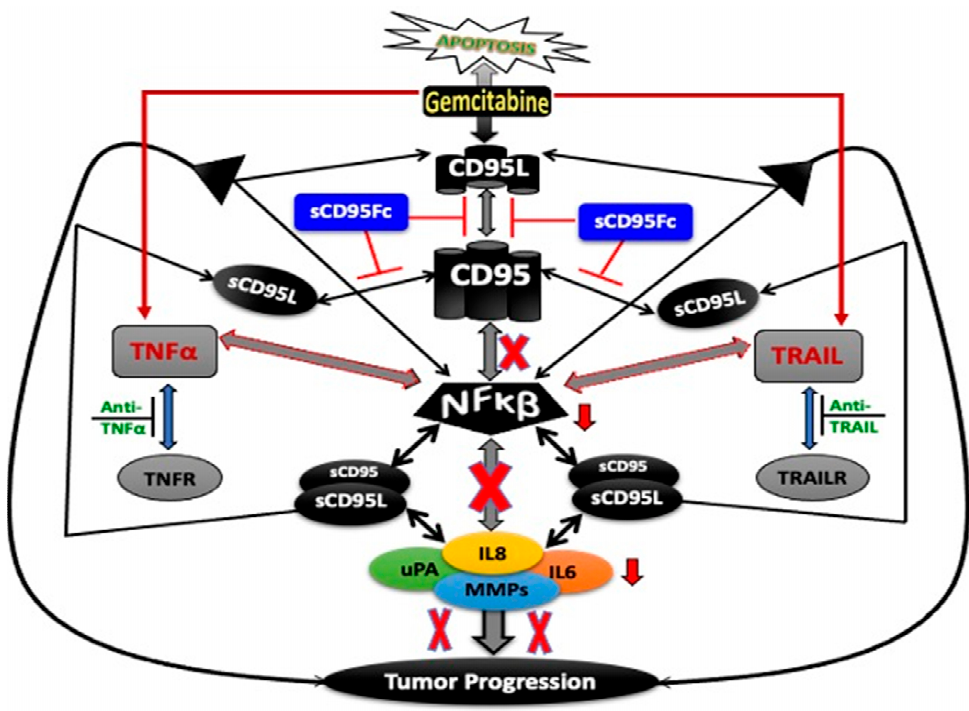
Figure 9. Schematic representation of the mechanism of the interaction amongst TNF- α , TRAIL and CD95L and its impact on chemotherapy. It is the simple chart showing these three signaling cascades crossing over each other’s functions through sharing a common transcription factor NF κ B and sub- sequently inducing expression and secretion of PICs as well as TAPs. Further, it shows how blocking of the CD95L may alter the production of PICs and inflammation derived tumor progression through multiple signals initiated by TNF- α or TRAIL and thus improve the chemotherapeutic effects of gem- citabine.